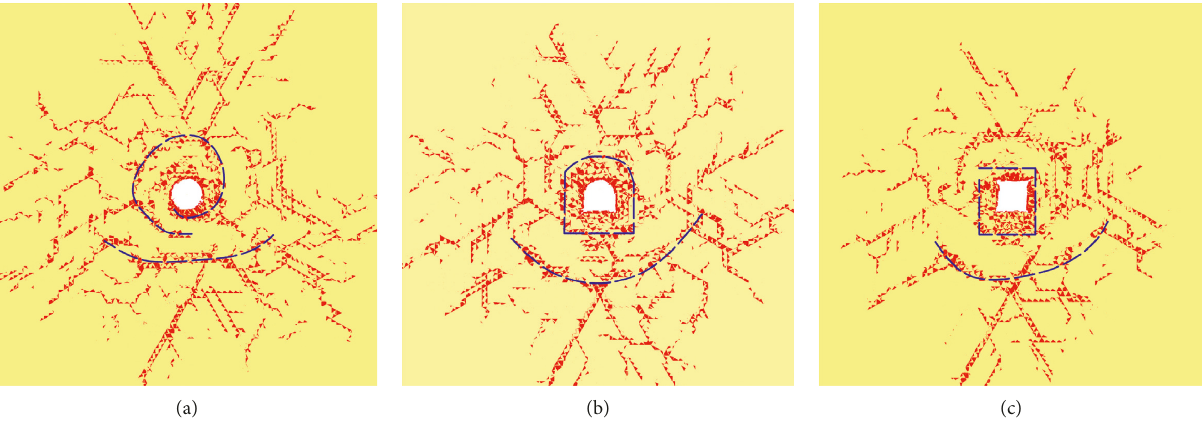
Figure 13: Fracture distribution around the roadway boundary using different roadway shape model: (a) circular roadway, (b) semicircular arch roadway, and (c) rectangular